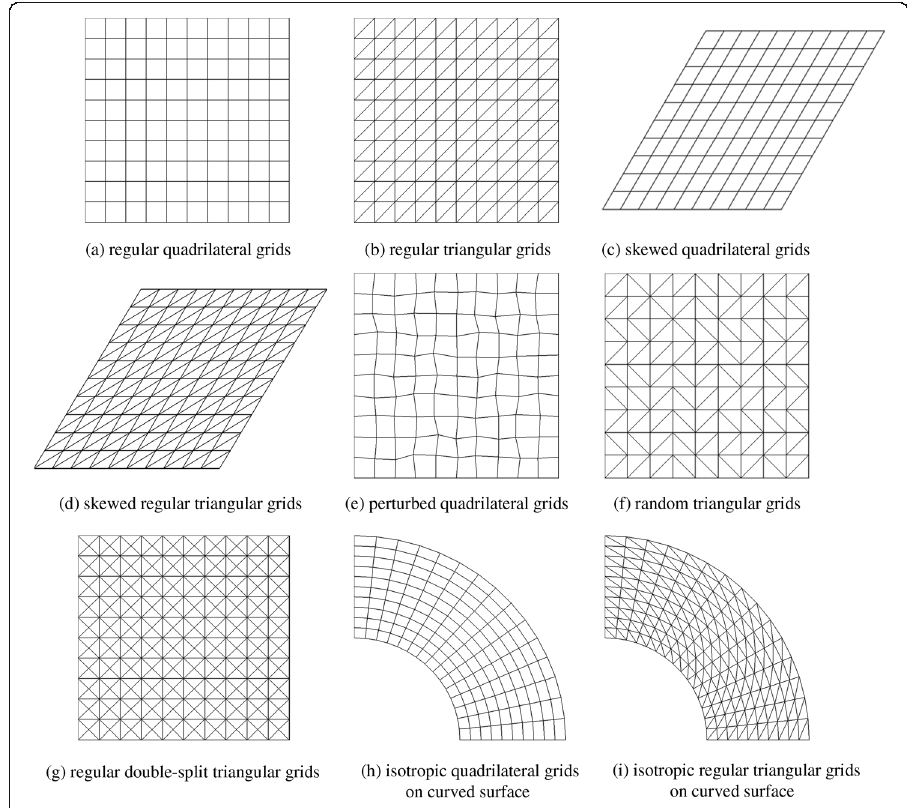
Fig. 8 Typical 2D isotropic grids. a Regular quadrilateral grids. b Regular triangular grids. c Skewed quadrilateral grids. d Skewed regular triangular grids. e Perturbed quadrilateral grids. f Random triangular grids. g Regular double-split triangular grids. h Isotropic quadrilateral grids on curved surface. i Isotropic regular triangular grids on curved